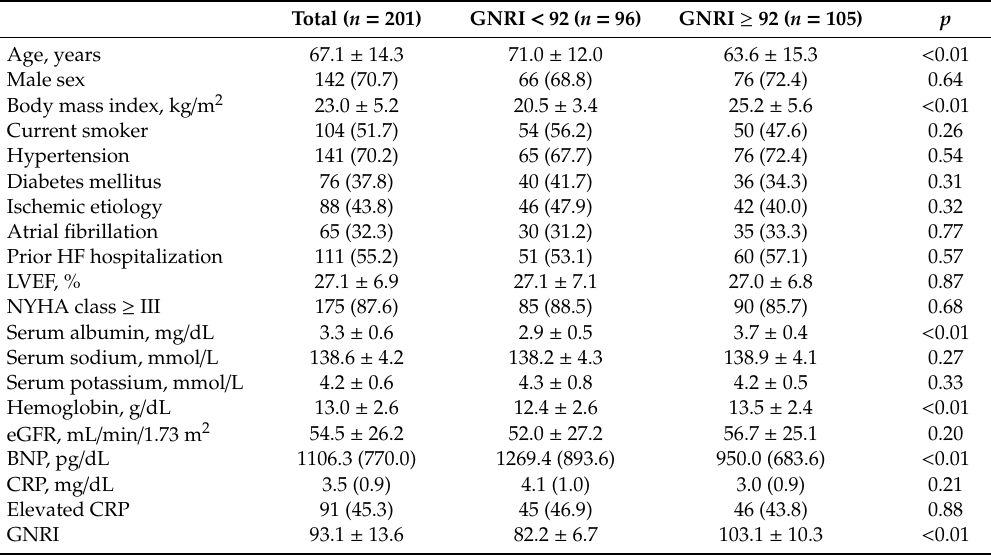
Table 1. Characteristics of patients with HFrEF.